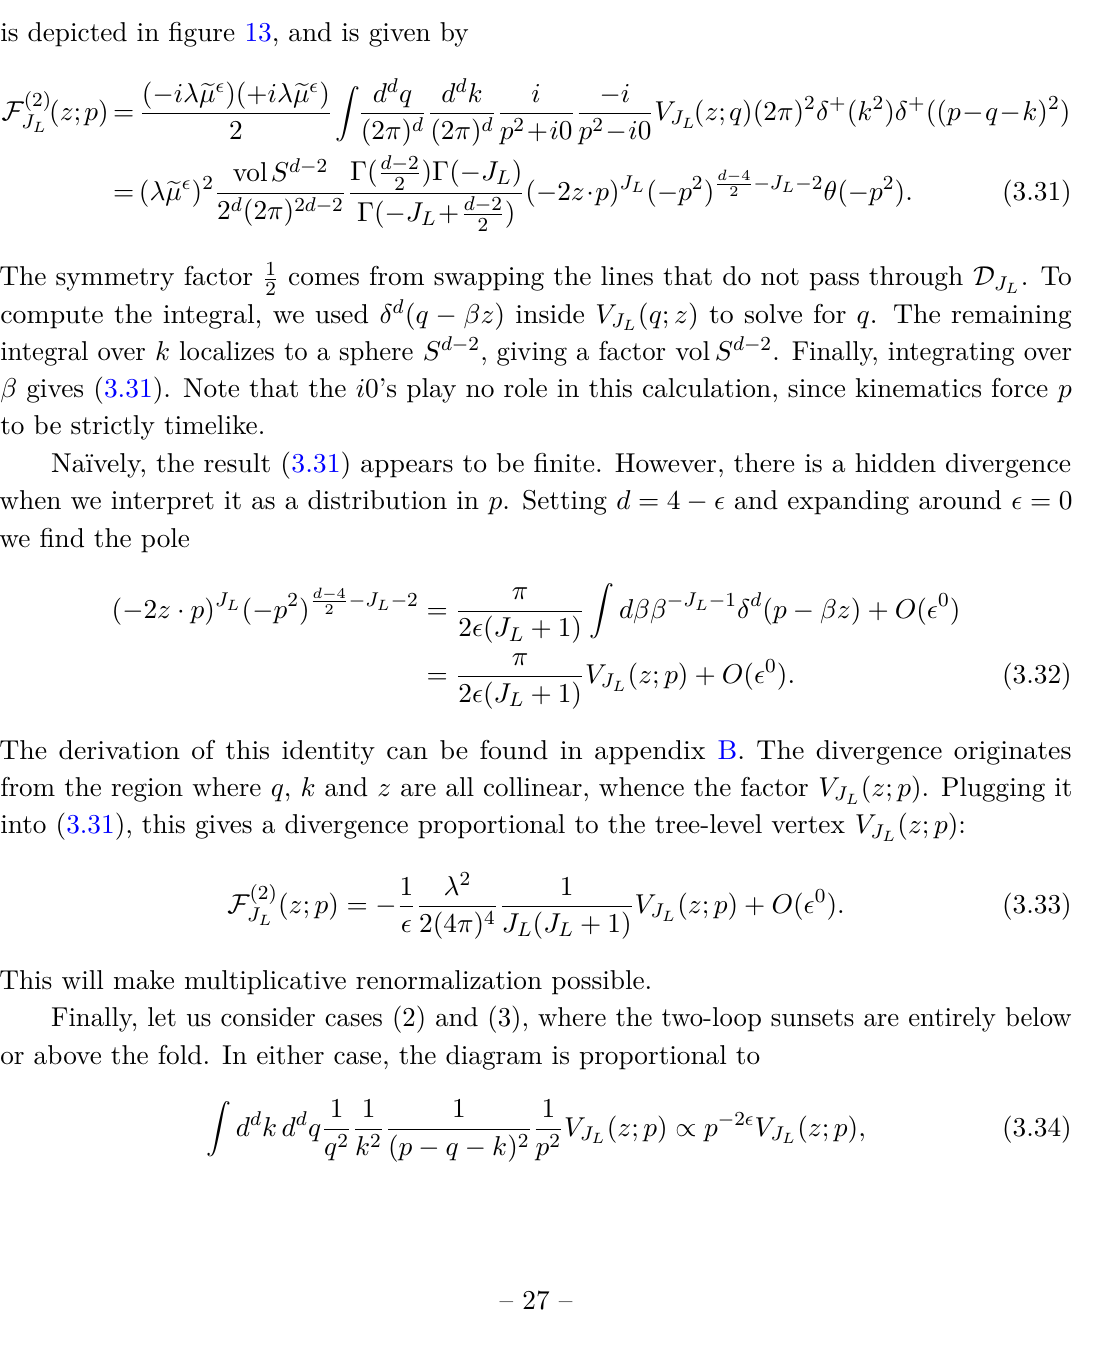
Figure 13. Two loop correction to the vertex V J upper